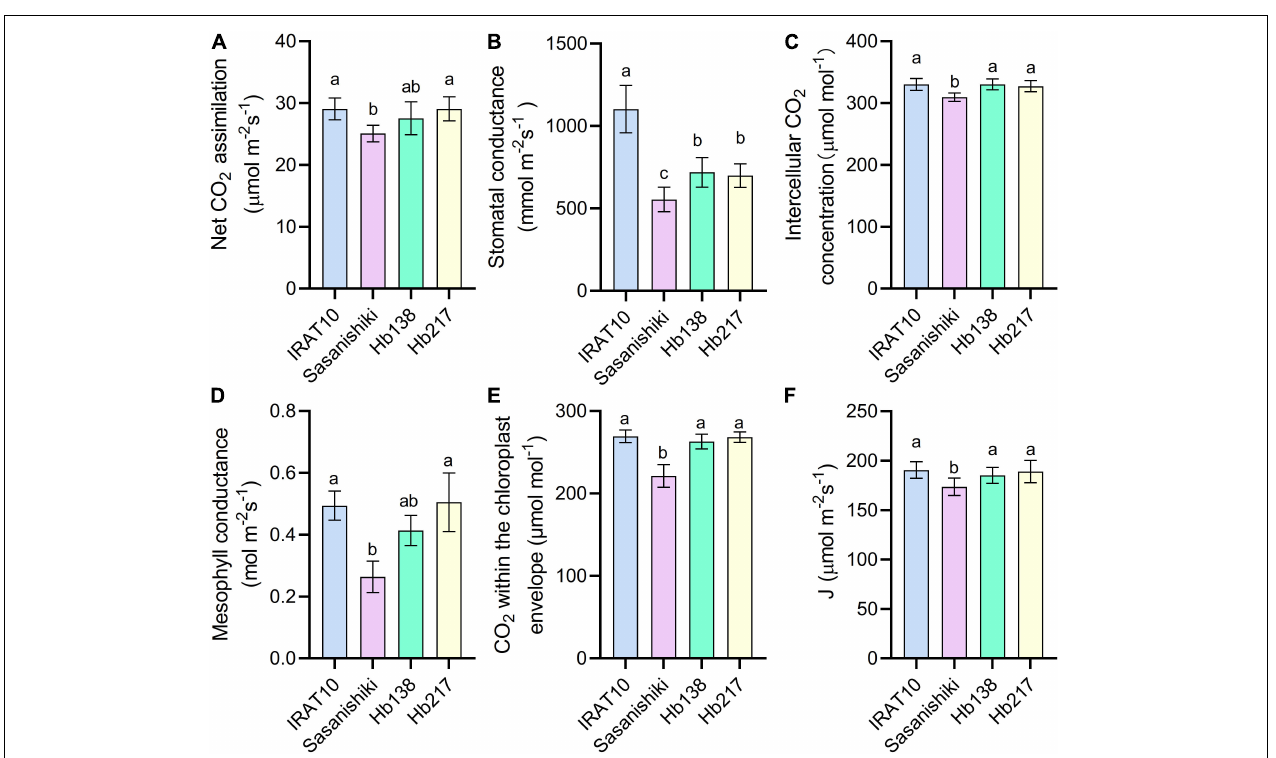
FIGURE 3 | Stomatal size (A) , stomatal density (B) and the maximum theoretical stomatal diffusive conductance (g S max ) (C) in the flag leaves of tested varieties. Values are means ± standard error. Different letters indicate significant statistical differences among tested varieties at the 0.05 probability level.